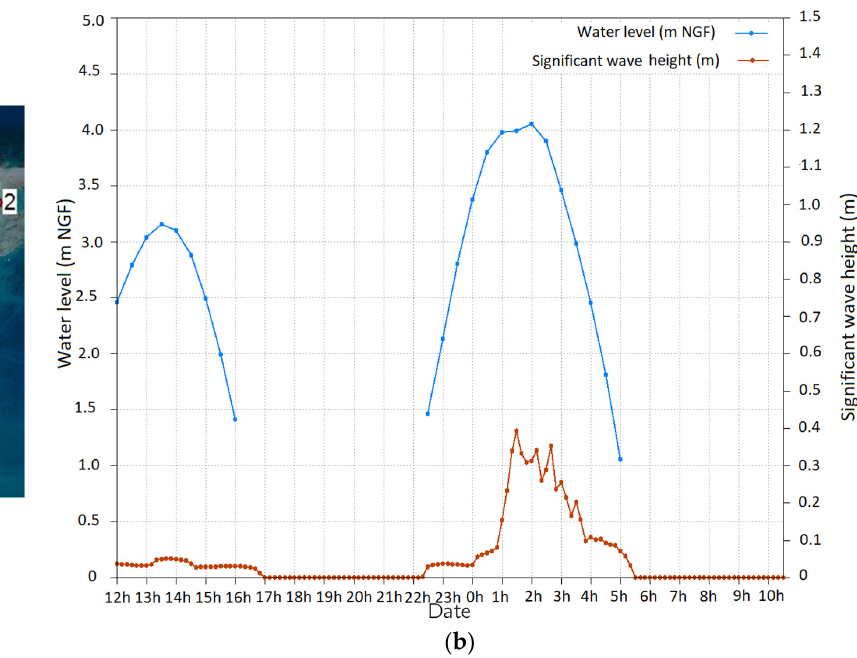
Figure 8. Water level and significant wave height on the Loix coast ( a ) localization of temporal series; ( b ) representation of values collected from point 6. Altitudes are given using the NGF/IGN69 (French reference